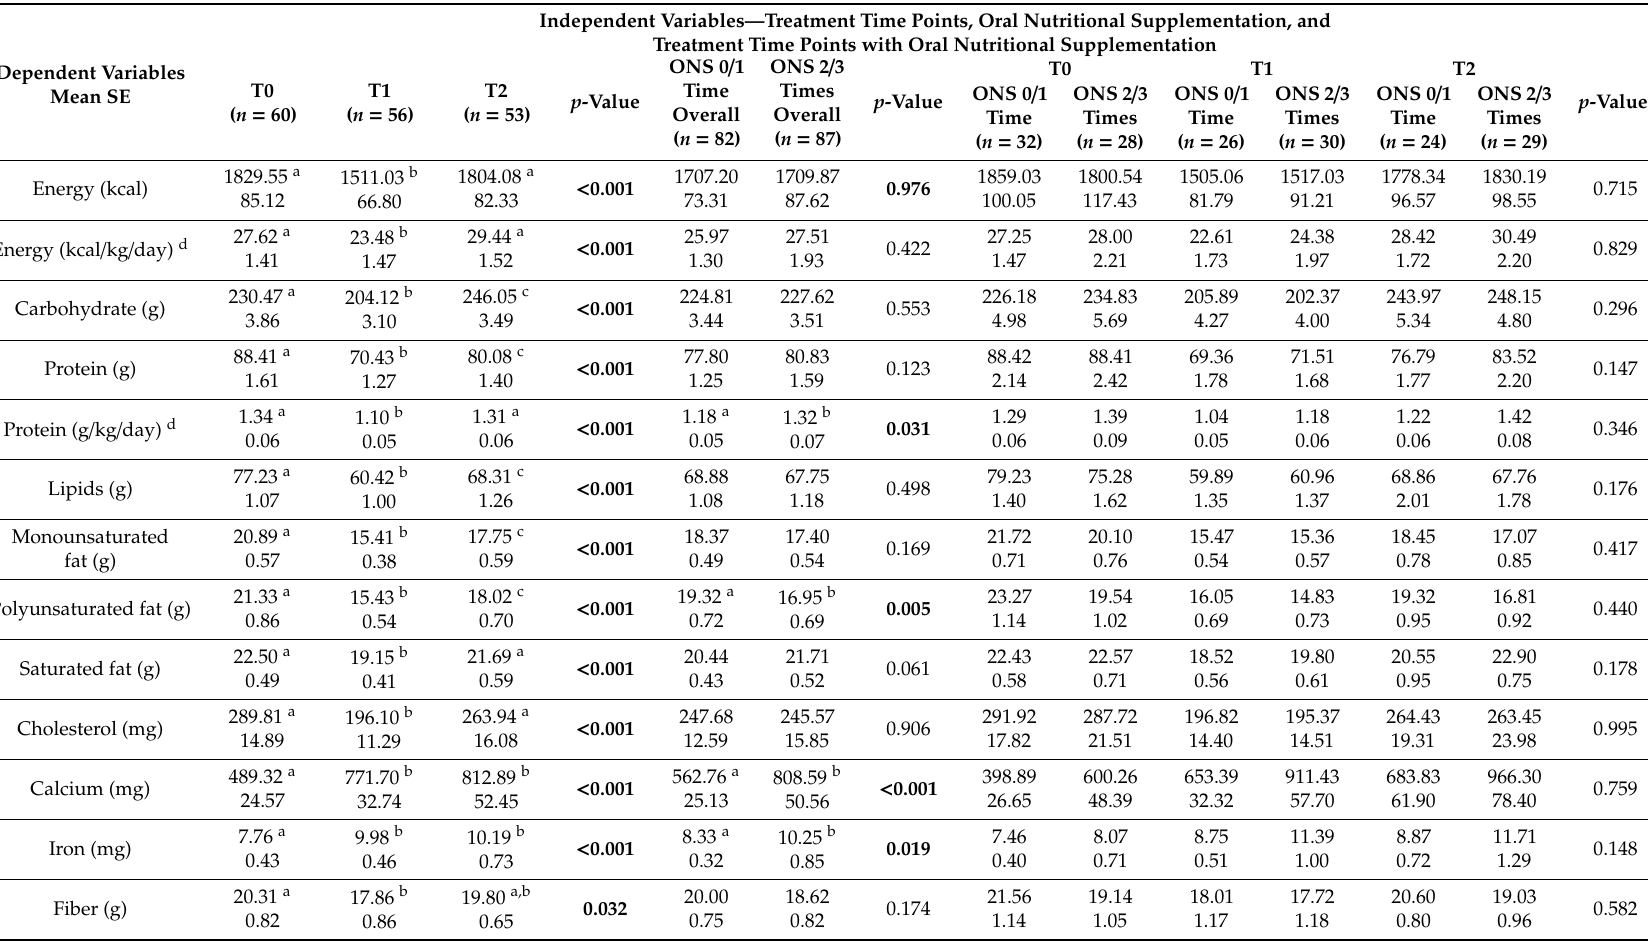
Table 2. Association of treatment time points and oral nutritional supplementation on energy, macro-, and micronutrient intake in head and neck cancer patients during (chemo)